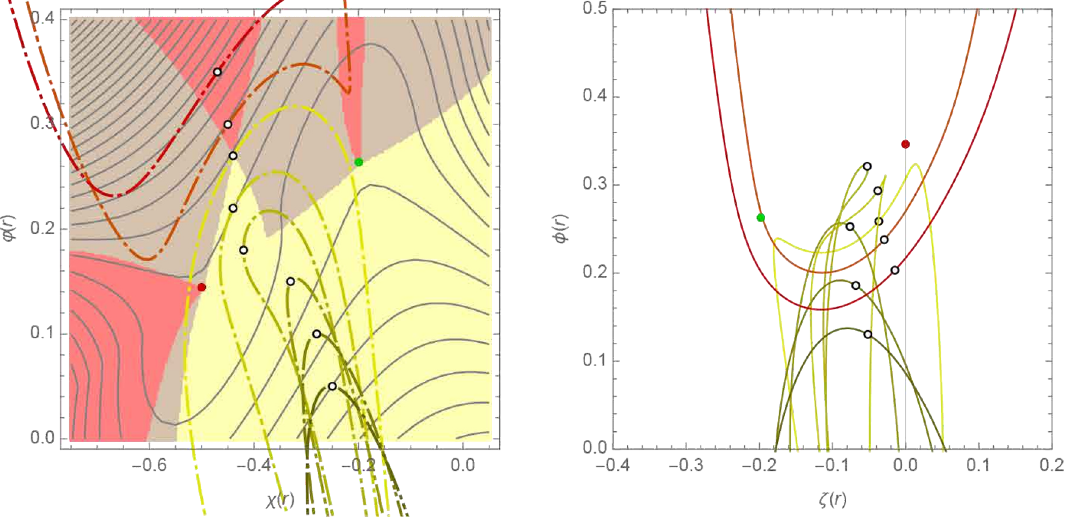
Figure 14. Space of N = 1 Janus solutions with SU(3) symmetry that approach U(3) and G 2 critical